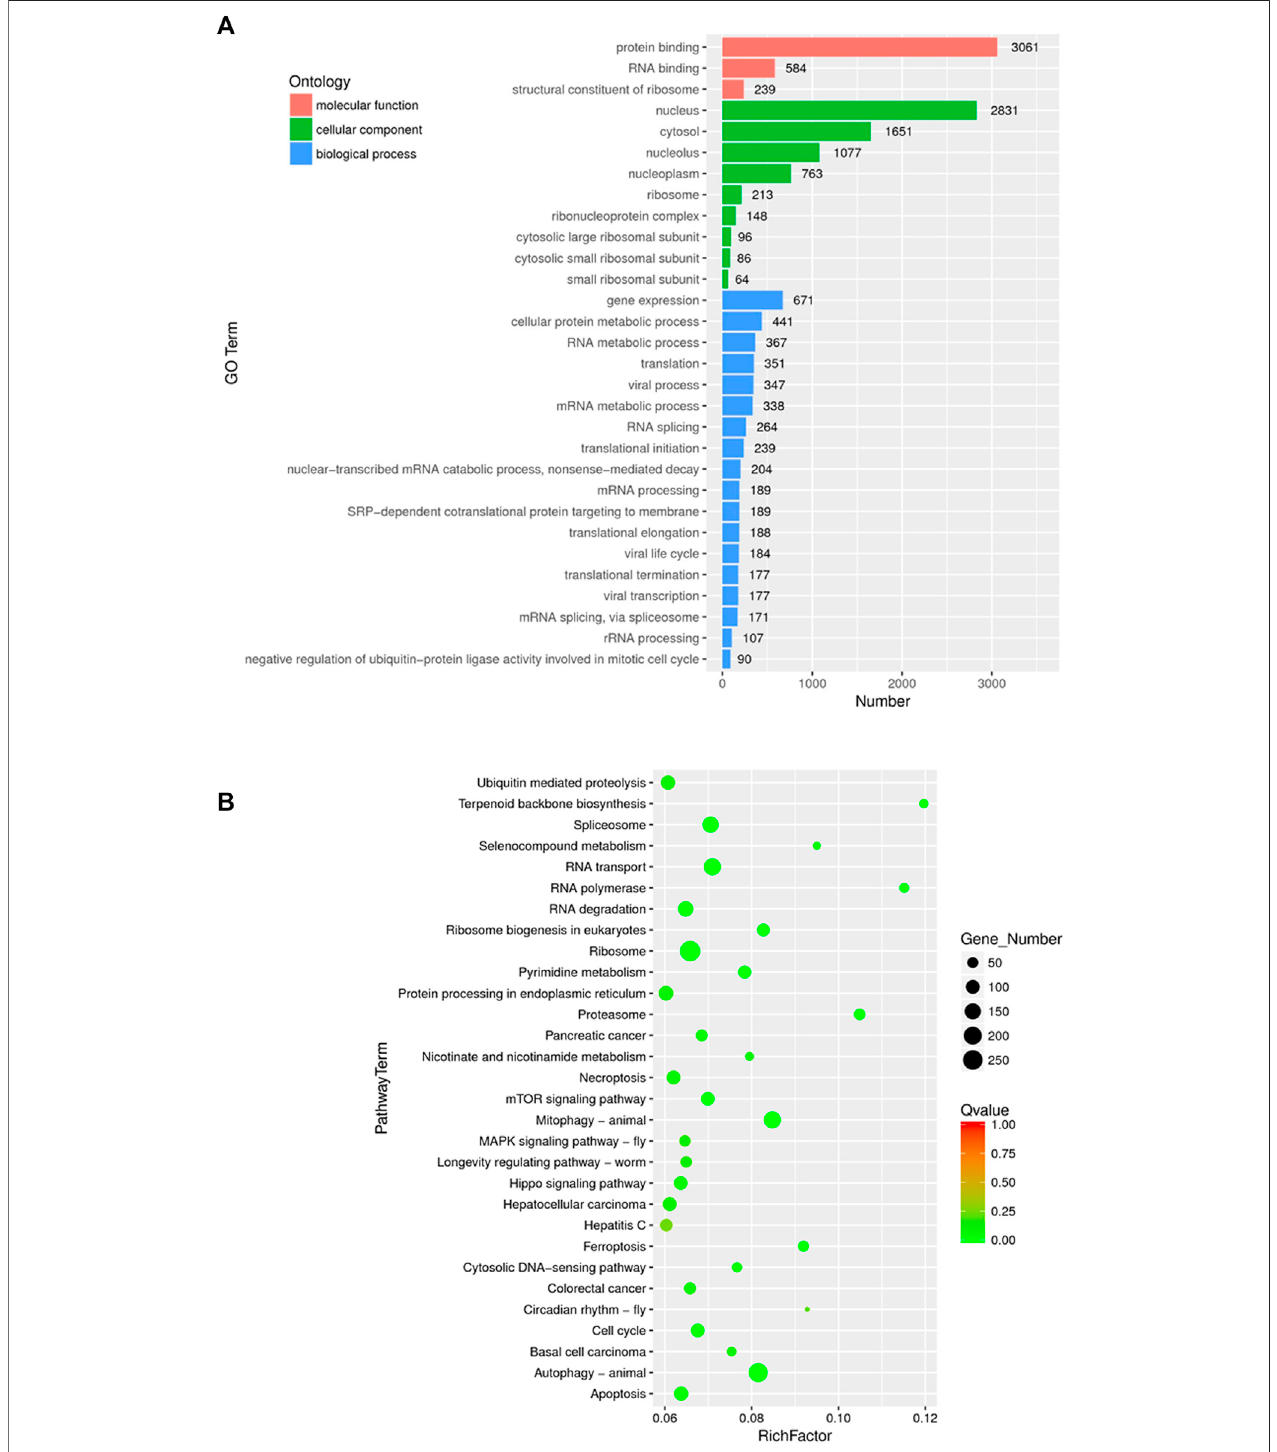
FIGURE 3 | Functionally organized GO term and KEGG pathway enrichment of DEGs in WGM extracts-treated Hep3B cells. (A) Gene ontology (GO) analysis was used topredictthepotentialfunctionsoftheDEGsinbiologicalprocess, molecular functionand cellularcomponent.Differentiallyexpressed geneswereselectedbased on more than 2-fold expression changes and the p -value was < 0.05. (B) The bubble plot of KEGG pathway enrichments of the DEGs between WGM extracts-treated and control samples. Rich factors are presented as enrichment degree of DEGs. The y-axis shows the names of the enriched pathways. The Q-value, which is the namegiventotheadjusted p -valuesfoundusinganoptimizedfalsediscovery rateapproach,isrepresentedbycolorscale.Greenrepresentshighsigni fi cance,whilered represents low. The number of DEGs is indicated by the size of a circle. ( n = 3)